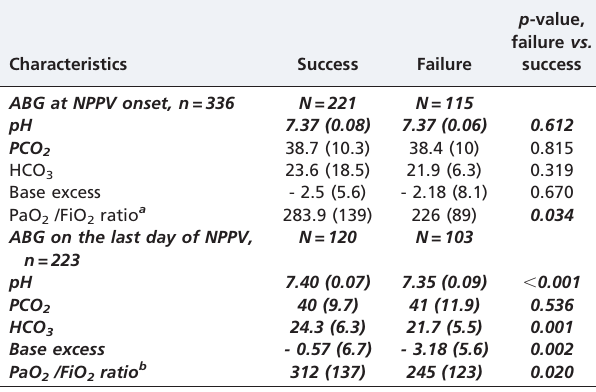
Table 2 - Arterial blood gas analysis at NPPV onset and on the last noninvasive positive-pressure ventilation day.